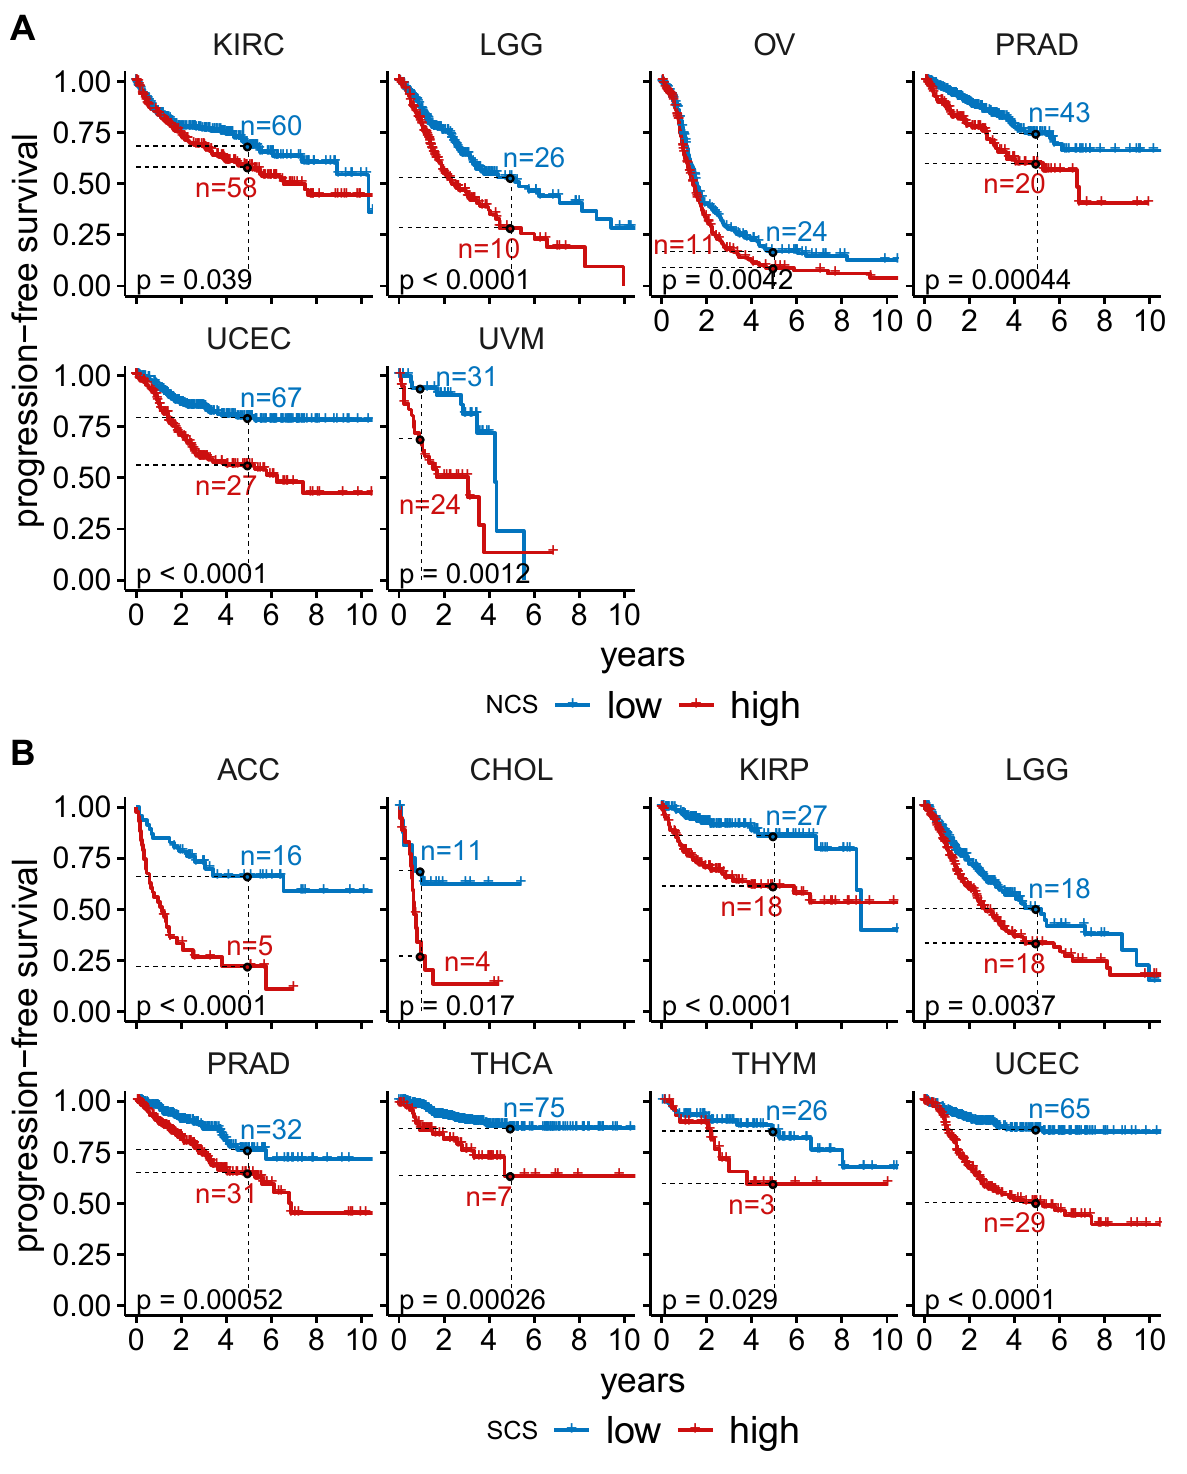
Figure A4. ( A ) Progression-free survival in six cancer types where significant differences between high- and low-NCS groups were observed. ( B ) Progression-free survival in eight cancer types where significant differences between high- and low-SCS groups were